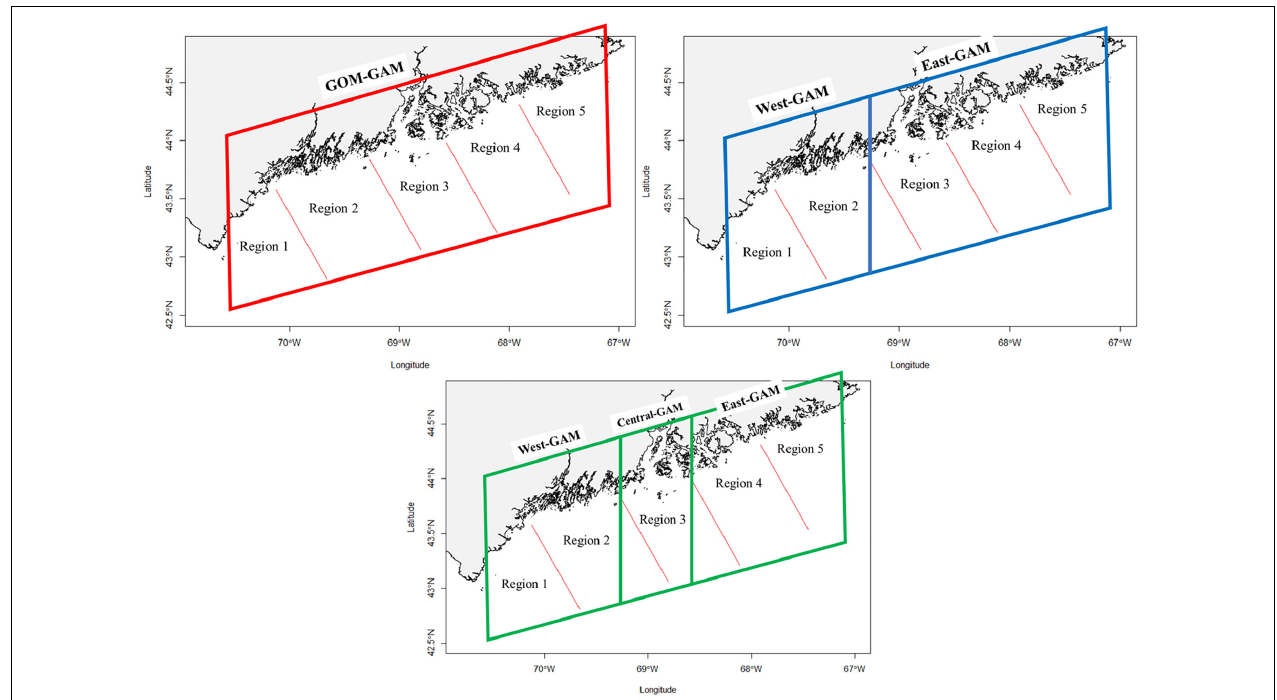
FIGURE 2 | Visual representation of each model utilized in this study. Each colored quadrilateral represents a separate GAM that was ran on the observed data points contained within that area. Red lines designate bottom trawl survey regional